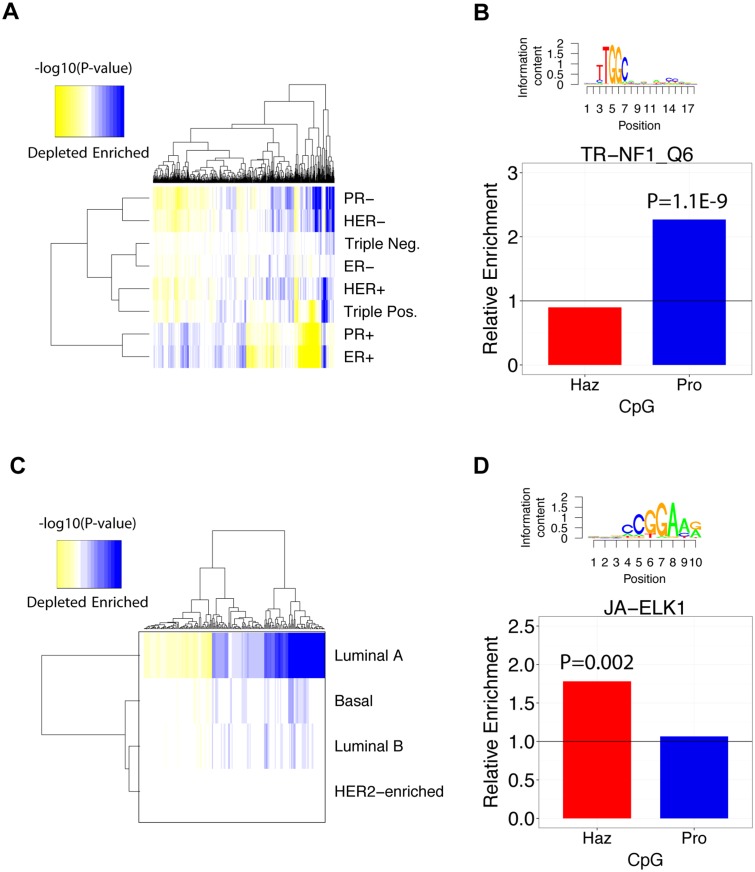
TF binding motifs enriched in histological and intrinsic subtypes of breast cancer.
A) Hierarchical clustering of -log10(P-values) of TF motifs enriched in histological breast cancer subtypes. Only TF motifs enriched with P<0.05 were included in the clustering procedure. B) Enrichment values of TR-NF1_Q6 in triple-negative breast cancer. C) Hierarchical clustering of -log10(P-values) of TF binding motifs in intrinsic breast cancer subtypes. D) Enrichment values of JA-ELK1 in basal breast cancer. A, C) Enrichment of motifs is shown in blue and depletion is shown in yellow.